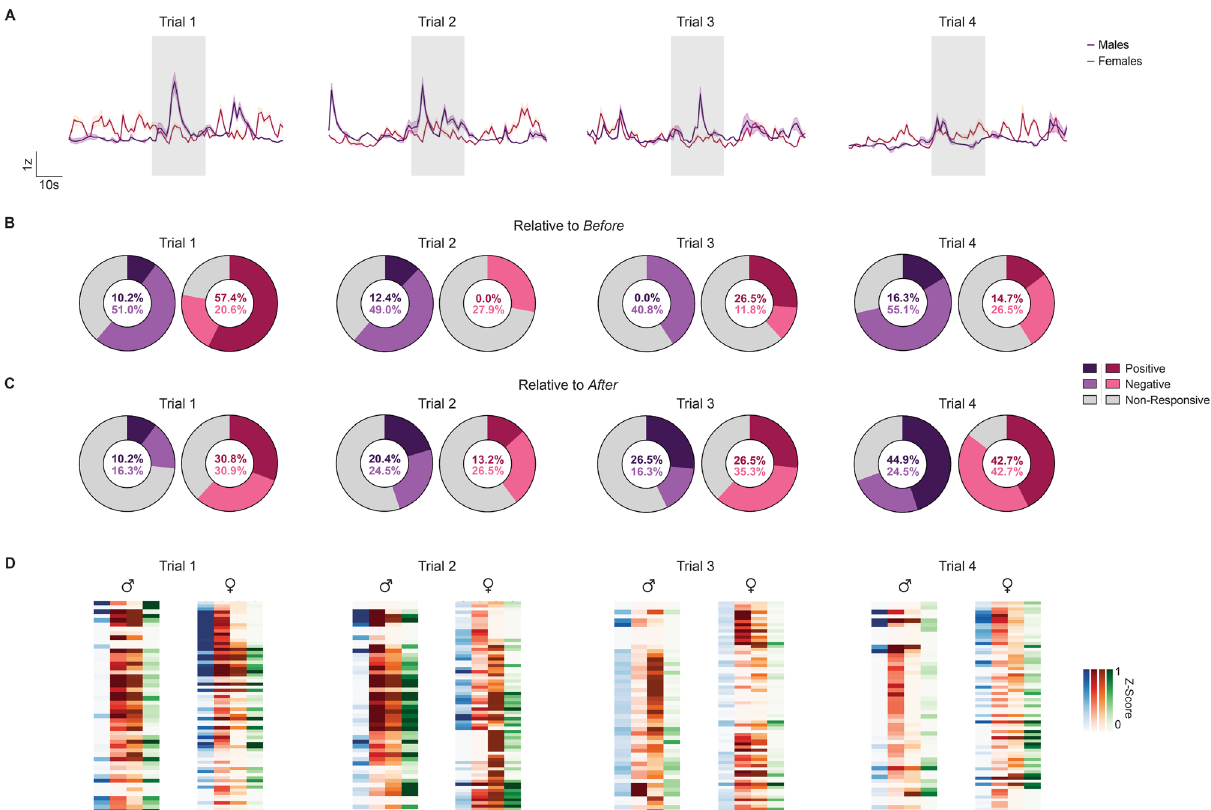
Figure 3. Progression of BNST CRF Activity Across Noxious Heat Exposure Trials. ( A ) Average BNST CRF traces of male (purple; n = 49 cells / 7–30 cells per mouse / 3 mice total) and female (magenta; n = 68 cells / 8–19 cells per mouse / 5 mice total) subjects by trial. Within each representative time window, the maximum heat duration (20 s) is indicated in the transparent blue block. ( B-C ) Percentage of pain responsive BNST CRF neurons for male (purple) and female (magenta) subjects were determined relative to epochs surrounding the onset of ( B ) heat exposure [“Relative to Before ”] and ( C ) paw withdrawal [“Relative to After ”] in trials 1–4. Positive, negative, and non-responsive cells are indicated by darker purple/magenta, lighter purple/magenta, and grey respectively (Wilcoxon rank-sum, P < 0.05). Comparisons by trial and sex relative to the epochs surrounding heat onset (Two-way mixed-model ANOVA with Sidak’s post hoc: no Trial × Sex interaction [F(3, 18) = 0.0466, P = 0.9862] or main effect of Trial [F(1.092, 6.553) = 0.4473, P = 0.5435] and Sex [F(1, 6) = 1.510, P = 0.2651]) and paw withdrawal (Two-way mixed-model ANOVA with Sidak’s post hoc: no Trial × Sex interaction [F(3, 18) = 0.3670, P = 0.7777] or main effect of Trial [F(2.740, 16.44) = 0.3368, P = 0.7818] and Sex [F(1, 6) = 0.0008, P = 0.9776]) were not statistically significant. ( D ) Heatmap displaying the average z-score of individual BNST CRF neurons by epoch for male and female subjects in trials 1–4. Epochs are color-coded: Before (blue), Heat Start (red), Heat End (orange), and After (green), with darker shades of color corresponding to greater changes in Ca 2+ activity. Data are shown as mean ± SEM. * P < 0.05; ** P < 0.01; *** P < 0.001, **** P <